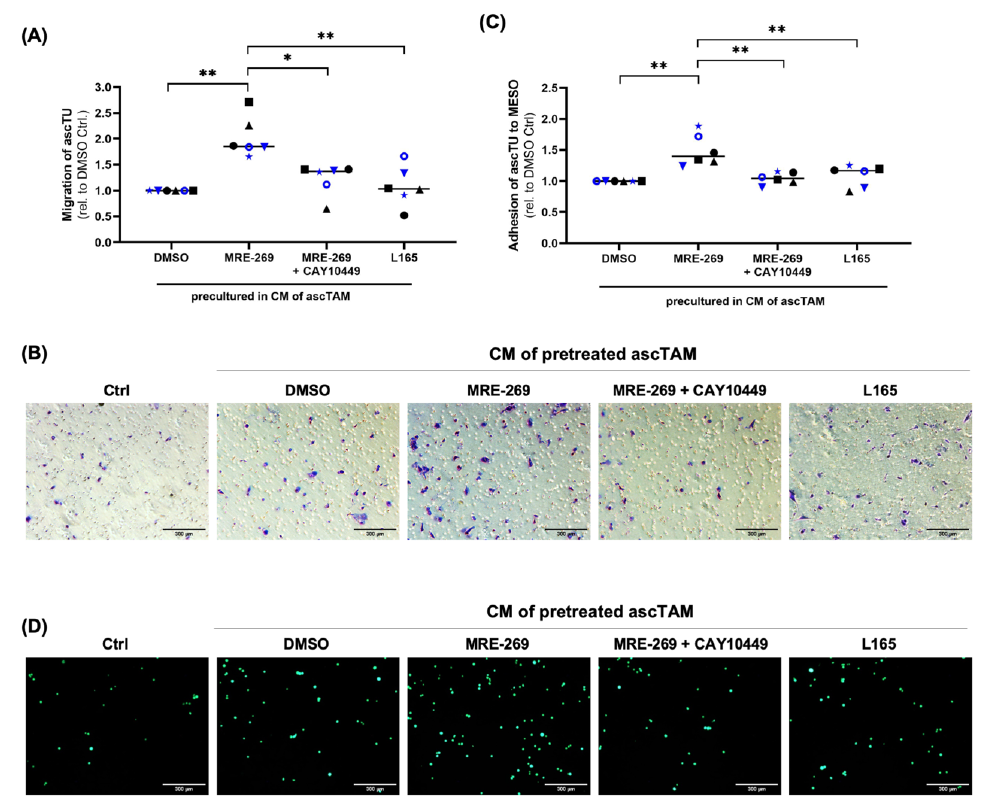
Figure 7. Pro-tumorigenic functions of PGI 2 -induced TAM secretomes. ( A ) Migration of primary ascTU pretreated for 24 h with conditioned media (CM) from ascTAM stimulated with MRE-269 (100 nM), MRE-269 (100 nM) + CAY10449 (1 µM) or PPAR β / δ agonist L165041 (1 µM). CM from ascTAM treated with DMSO was included as control. Migration was assessed in a Transwell format with 10% FCS as chemoattractant after 24 h and quantified relative to CM from DMSO control with primary ascTU from n = 2 patients (different colors) and TAM-conditioned medium from n = 6 patients (different symbols). ( B ) Representative microscopic pictures of migrated tumor cells after 24 h exposure to CM from ascTAM. ( C ) Adhesion of primary ascTU cells to a confluent monolayer of peritoneal mesothelial cells (MESO). ascTU (from n = 2 patients, indicated by different colors) were preincubated with CM from ascTAM (from n = 6 patients) stimulated as described above and labeled with CellTracker Green. Adhesion of ascTU to the MESO layer was evaluated in comparison to CM from ascTAM stimulated with DMSO as solvent control after 2 h of co-culture. ( D ) Representative microscopic pictures of tumor cell adhesion to MESO monolayer after 2 h exposure. Tumor cells were pretreated with CM from ascTAM pretreated with different ligands as indicated. Intactness of the MESO monolayer was verified by staining for the tight junctions scaffolding protein zonula occludens 1 (ZO1) (Supplementary Figure S1). One of the samples analyzed was a low-grade mucinous carcinoma (black triangles in A and C), which was not known at the time of the analysis (OC233 in Table S1). All other samples were isolated from HGSC patients. The data suggest that the effect of MRE-269 is not limited to HGSC. * p < 0.05, ** p < 0.01, by paired t test. Horizontal bars show the